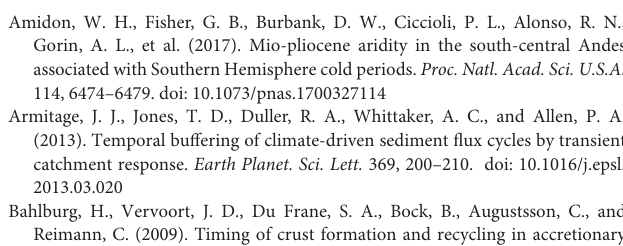
TABLE S1 | Detrital zircon U-Pb results. TABLE S2 | Percentage age group. TABLE S3 | Statistical coefficient results. TABLE S4 | Mixing model